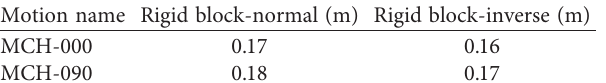
Figure 8. Four units of soil were identified in the soil profile: layer, and the thickness of Unit A was 2.3 m; Unit B con-